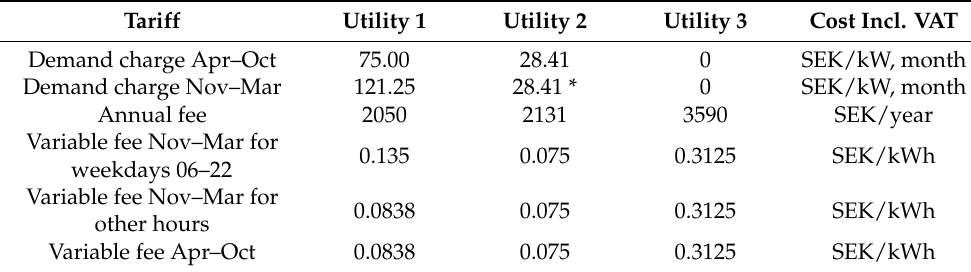
Table 1. Tariff structures for the three chosen